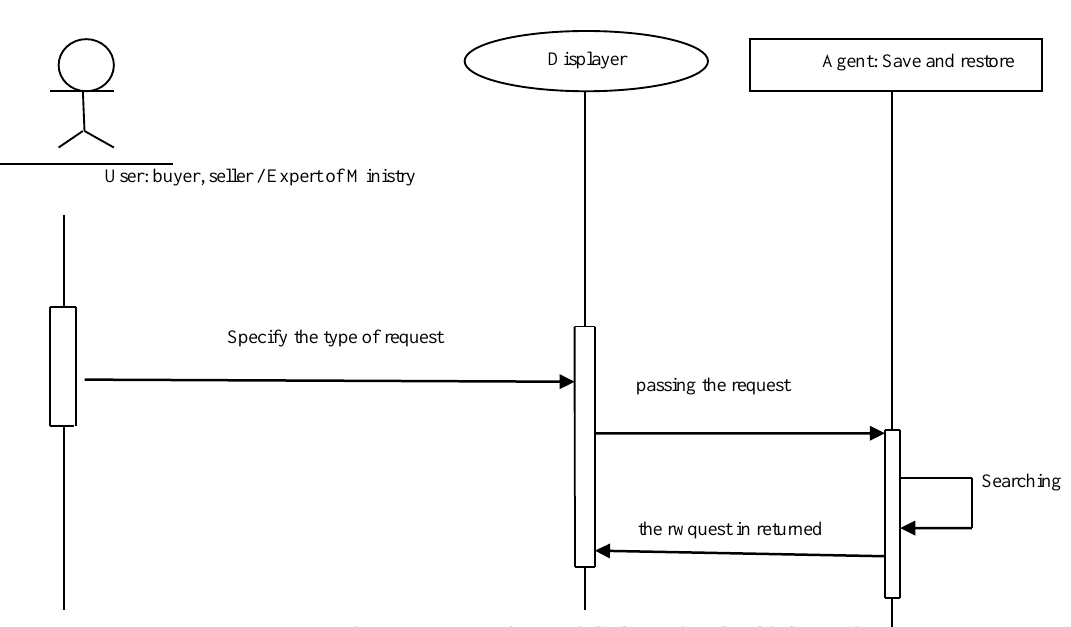
Figure 5. Interaction model of search role of information.